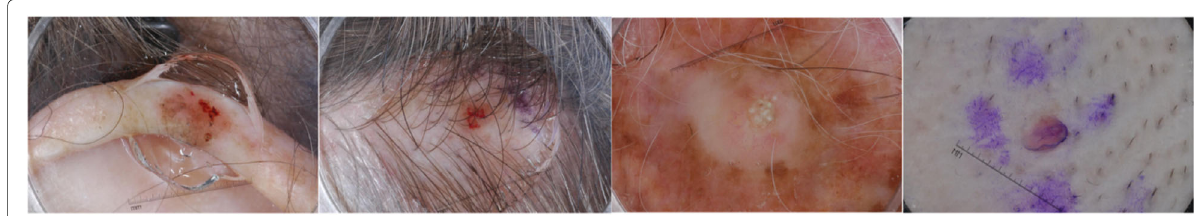
Fig. 1 Sample dermoscopic images from the ISBI 2017 Challenge: Skin Lesion Analysis Toward Melanoma Detection. The presence of artifacts such as hairs on the skin and inconsistent pigmentation making accurate skin lesion segmentation